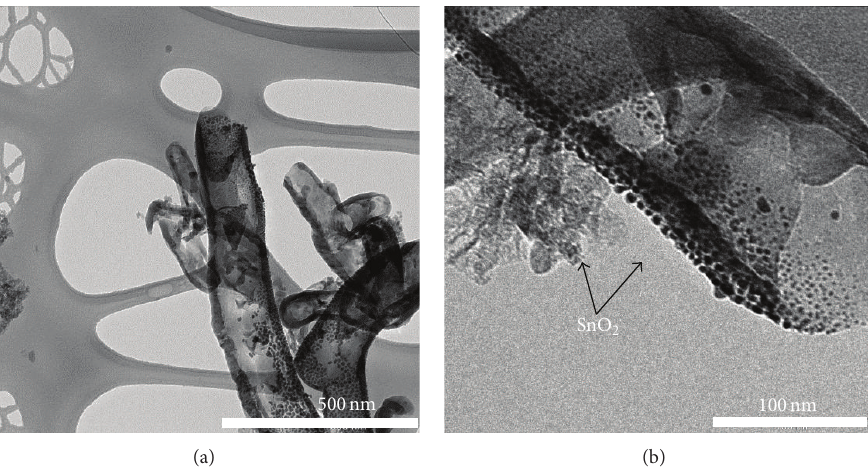
Figure 2: Transmission electron microscopy images of SnO 2 -CNT composite. (a) View of the composite structure and (b) higher magnification which shows the bamboo-like structure of the CNTs and the SnO 2 covered partially by the CNT.